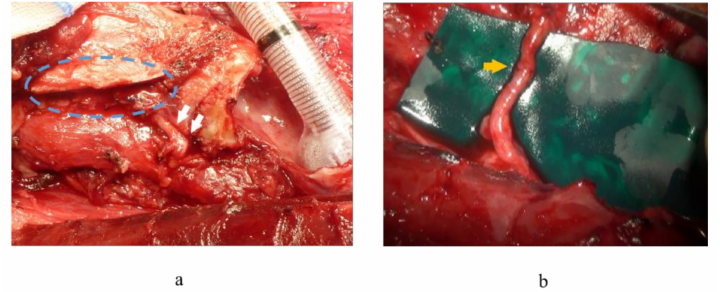
Figure 1. ( a ) Intraoperative findings after resection of the right recurrent laryngeal nerve (RLN), thyroid cartilage ( broken circle ), and inferior pharyngeal constrictor muscle with thyroid cancer. The distal edge of the resected RLN ( arrow ) was secured for the RLN reconstruction procedure. Head to the left. ( b ) Intraoperative finding of nerve transfer between the right RLN and the ansa cervicalis nerve ( arrow ). Head to the